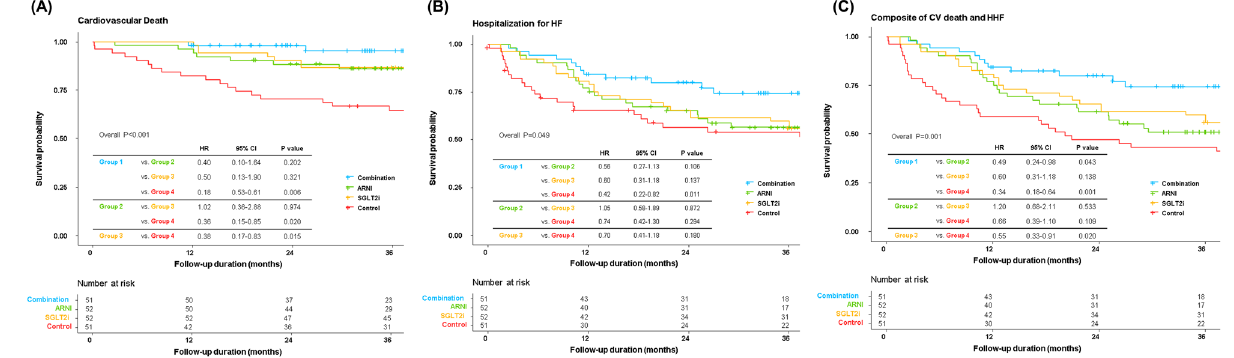
Figure 2. Event-free survival curves according to the groups. Kaplan–Meier curves comparing the risk of ( A ) cardiovascular (CV) death, ( B ) hospitalization for HF (HHF), and ( C ) composite of CV death and HHF, between the 4